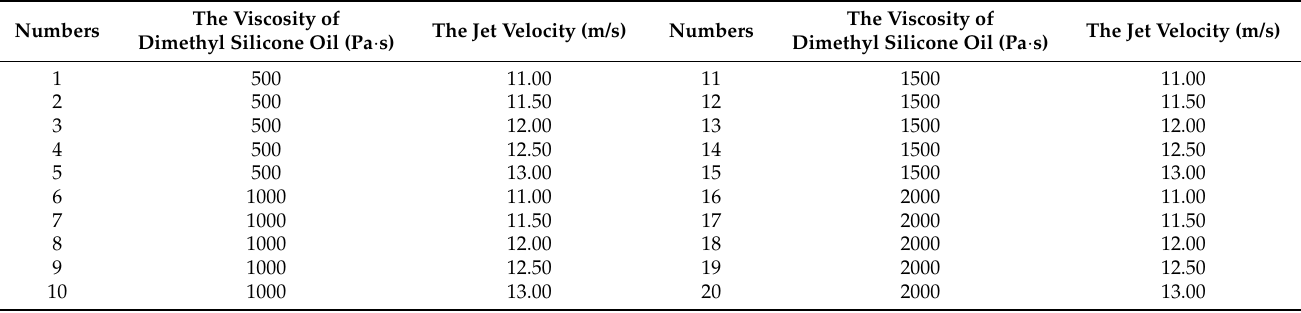
Table 4. Experimental